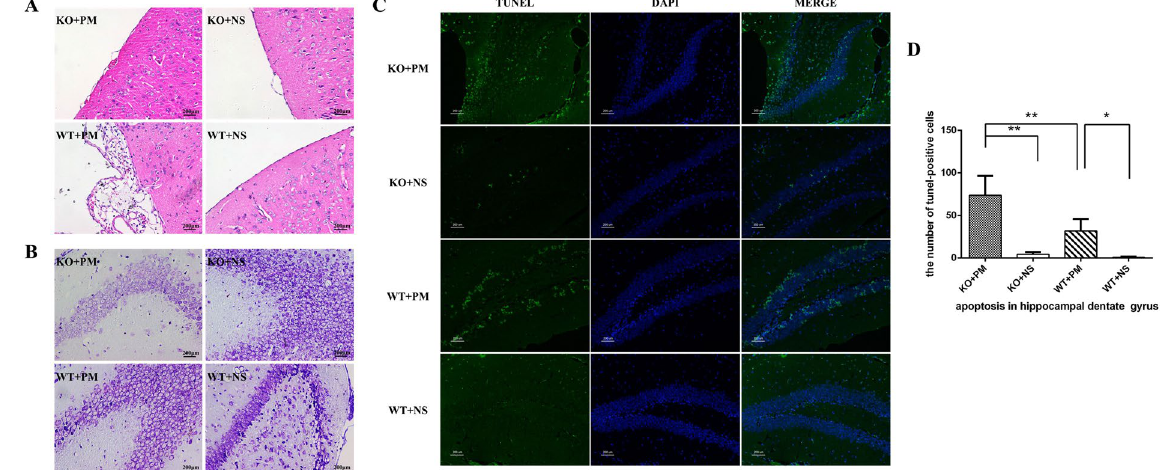
Figure 2. Effect of MyD88 deficiency on histological changes of mouse brains at 24 h after inoculation with S. pneumoniae . ( A ) H&E staining: Infected myd88 − / − mice showed slight neutrophile granulocyte exudate in the subarachnoid cavity, while infected wild-type mice showed vast inflammatory exudate in the subarachnoid cavity and ventricle, with hemorrhage-like spots in the parenchyma. Control groups had no pathological changes of meningitis, with a smooth meninx. ( B ) Nissl staining: In infected myd88 − / − mice group, the structure of most neurons in the hippocampus is incomplete, and Nissl staining is not uniform in the cytoplasm. In infected wild-type mice group, neuron loss is less severe than in infected myd88 − / − mice. Nissl staining in control groups had no difference. ( C ) TUNEL immunofluorescence: There are more TUNEL-positive cells in infected myd88 − / − mice than in infected wild-type mice. Few TUNEL-positive cells were observed in both control groups. ( D ) Quantitative analysis of the TUNEL results, * p < 0.05, ** p < 0.01. KO: knockout, PM: pneumoniae meningitis, WT: wild-type, NS: normal